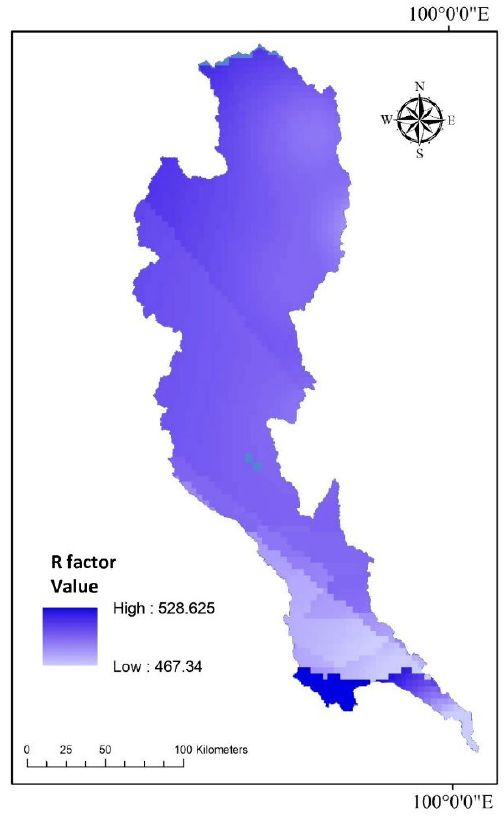
Figure 4. Erosivity factor map.